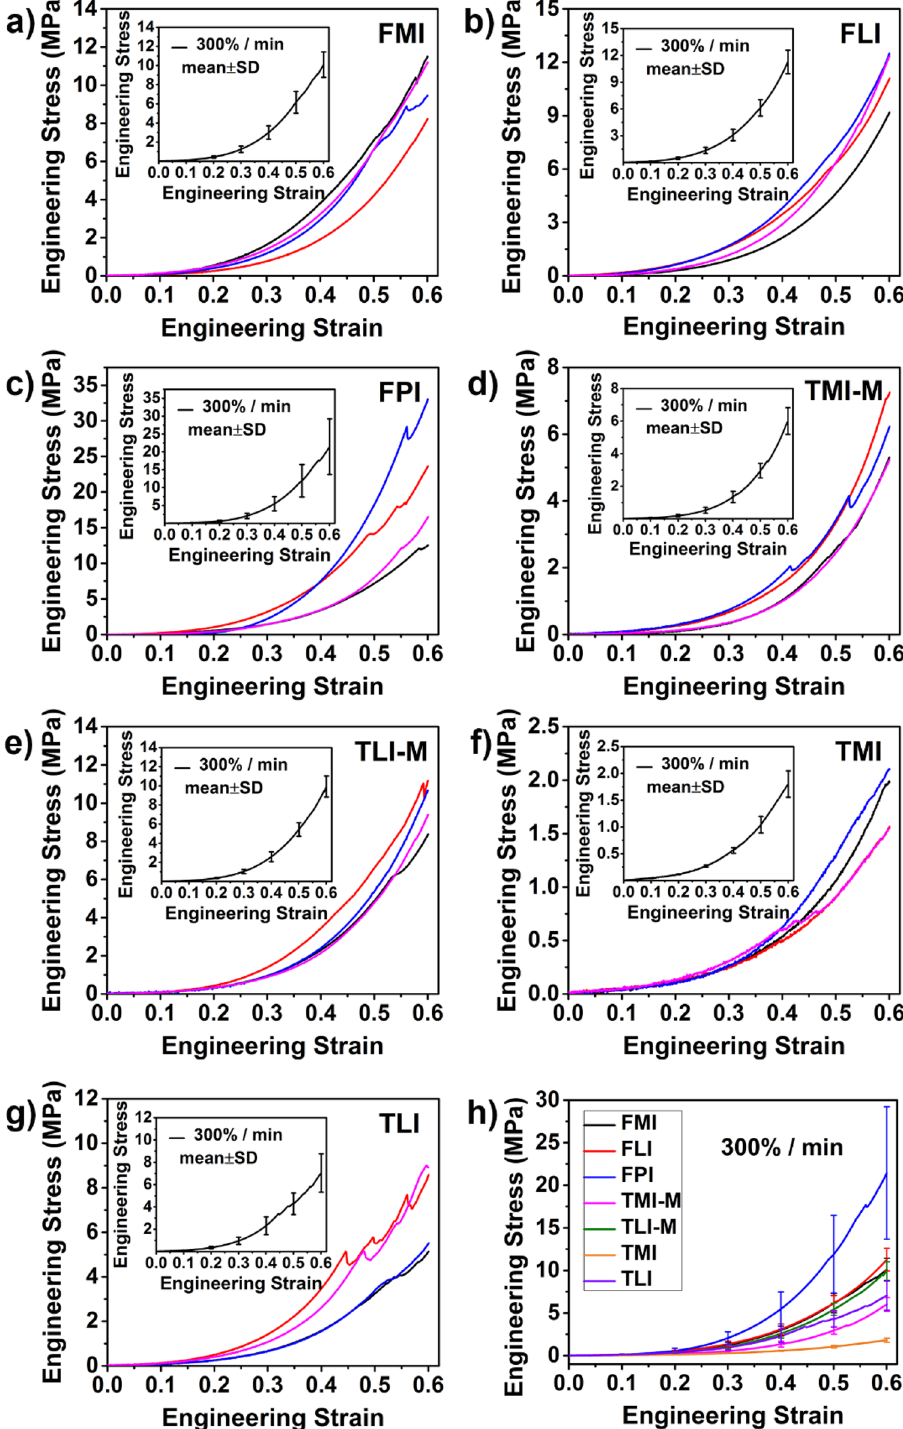
Figure 4. ( a – g ) Stress–strain curves of cartilage in predetermined regions at strain rate 300%/min. Inset: mean of four repetitions with error bar (± SD). ( h ) The comparison of mean stress–strain curves for seven regions at strain rate